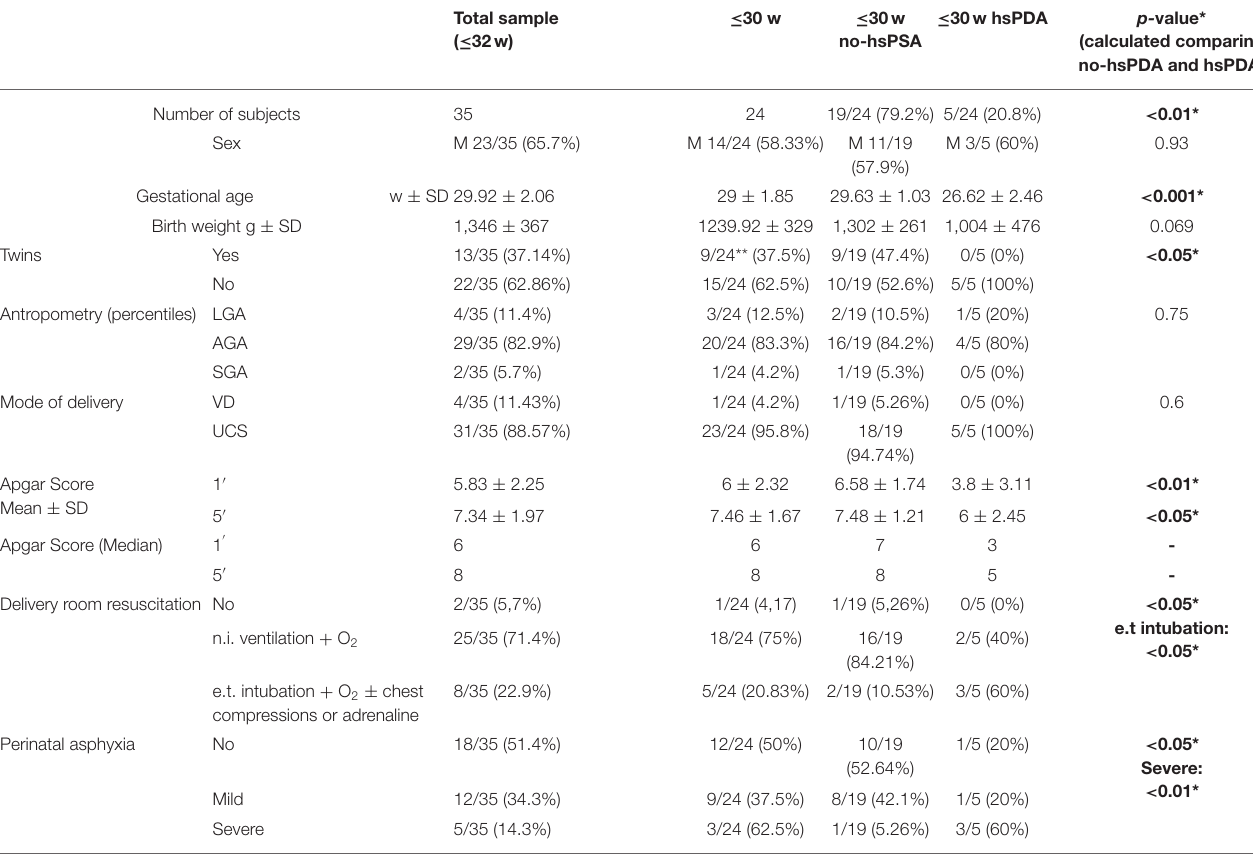
TABLE 2 | Perinatal